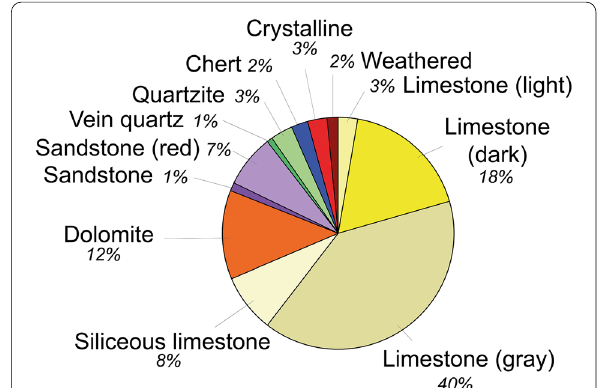
Fig. 9 Clast petrography of the gravels analysed at Chroobach